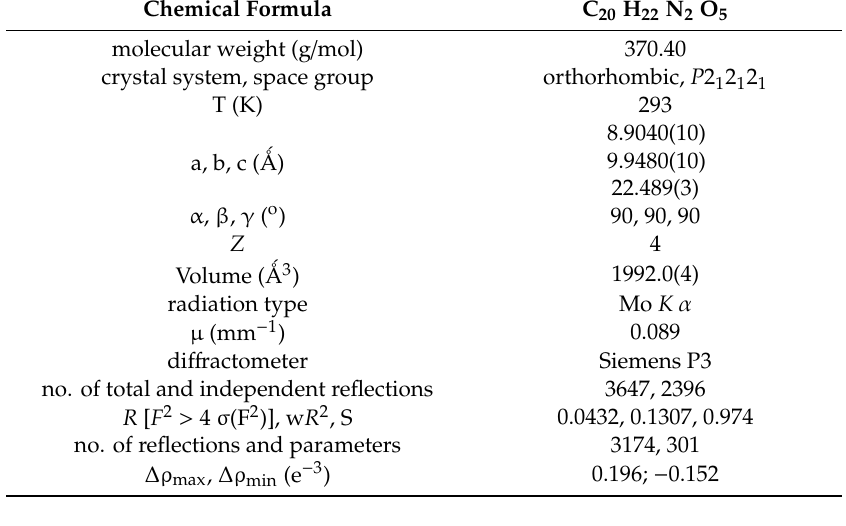
Table 1. Crystallographic data and structure refinement parameters for 1 .